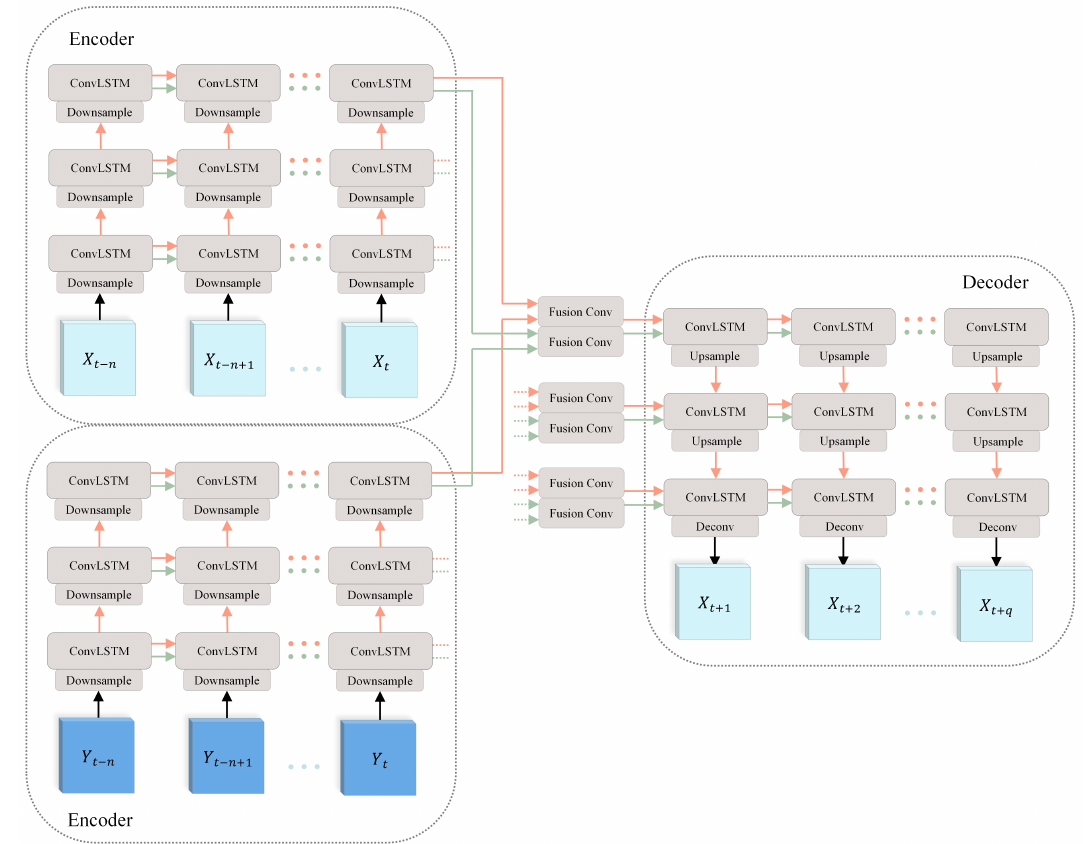
Figure 3. The dual-input late fusion ConvLSTM (LF-ConvLSTM) architecture. It contains two encoders, one decoder, and the fusion module. The two inputs are 3D tensors, defined as X t and Y t . LF-ConvLSTM forecasts the X t + 1 · · · X t + q in the future given the previous X t − n · · · X t and Y t − n · · · Y t including the current